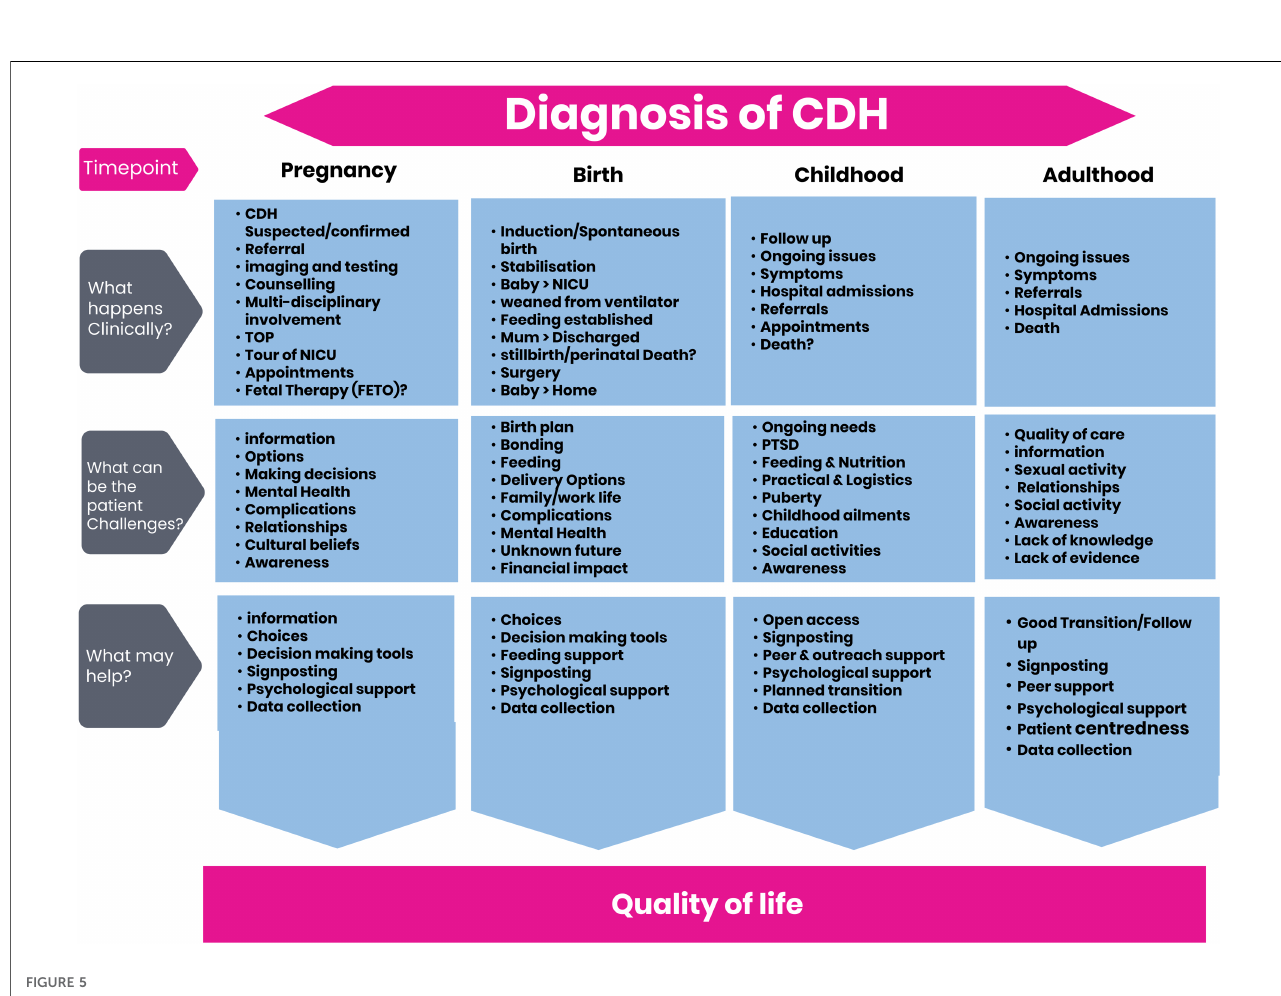
FIGURE 5 CDH Patient Journey